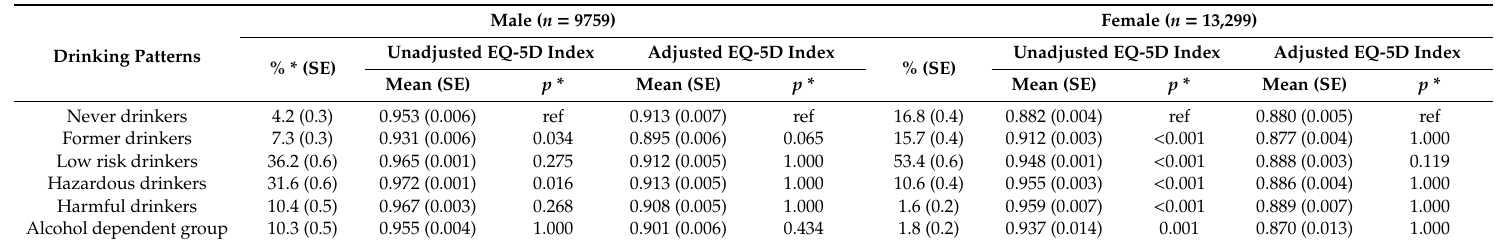
Table 3. Means of the EQ-5D index score according to alcohol drinking patterns by